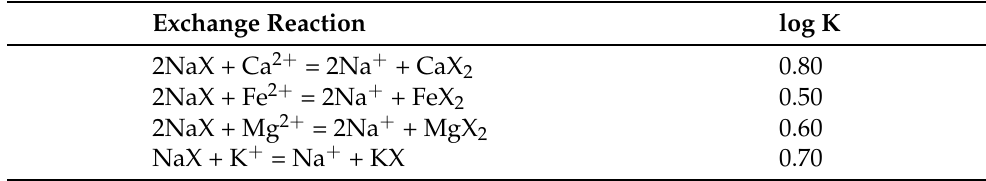
Table 6. MX-80 bentonite cation exchange reactions and log K at 25 ◦ C